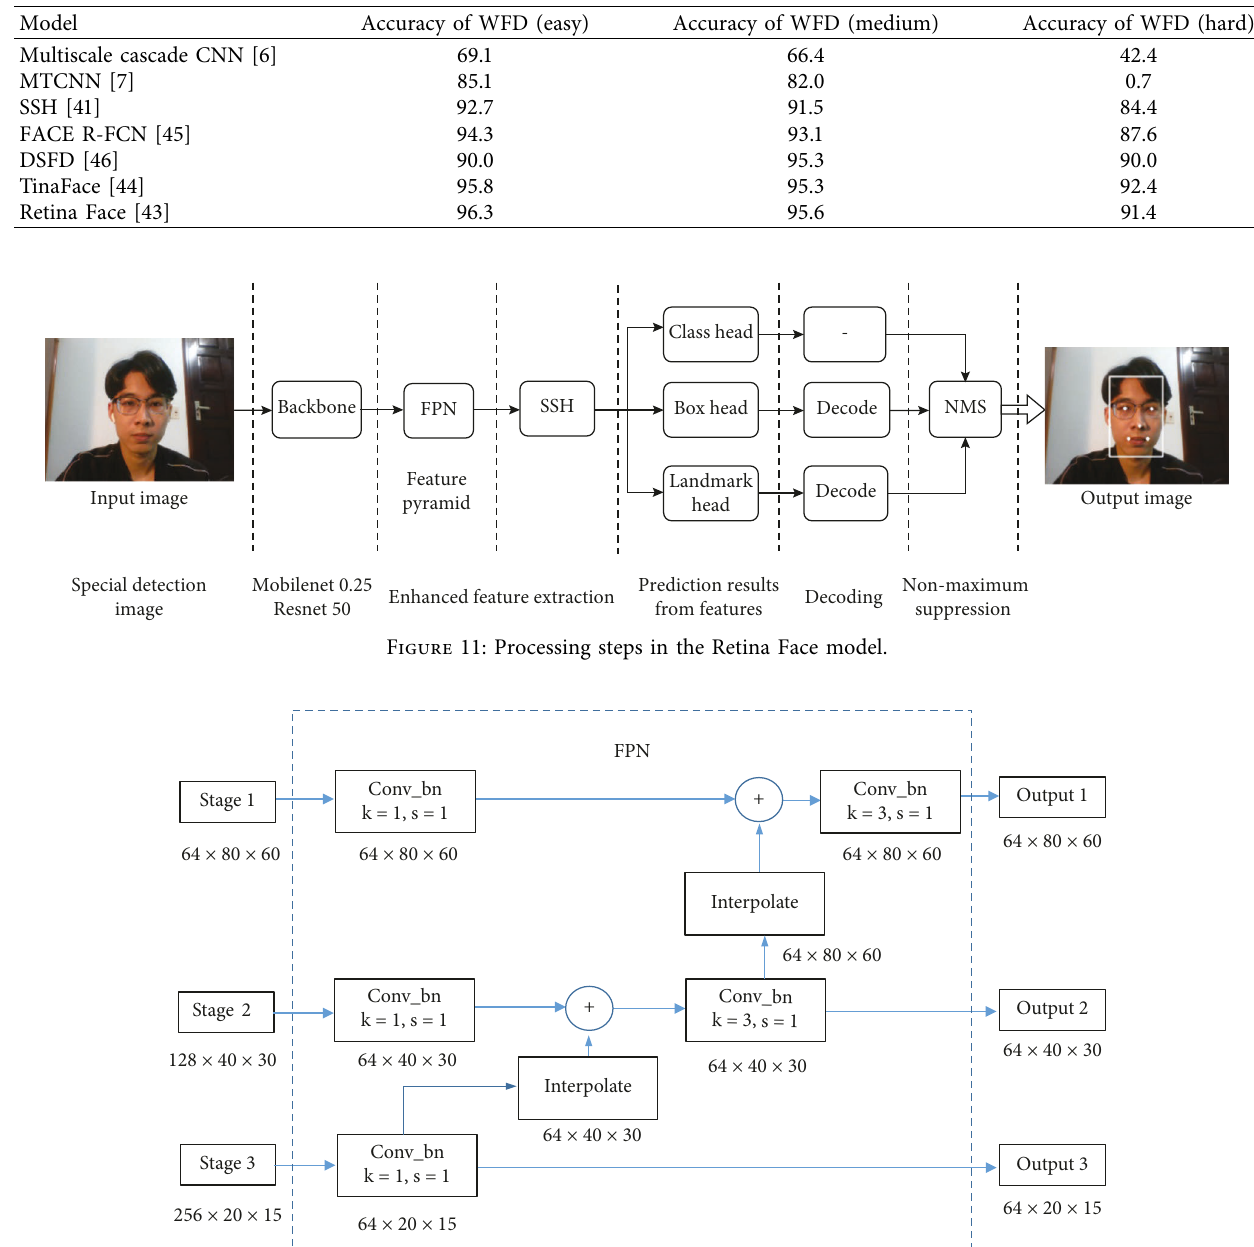
Table 1: Accuracy of face detection model on WIDER FACE.